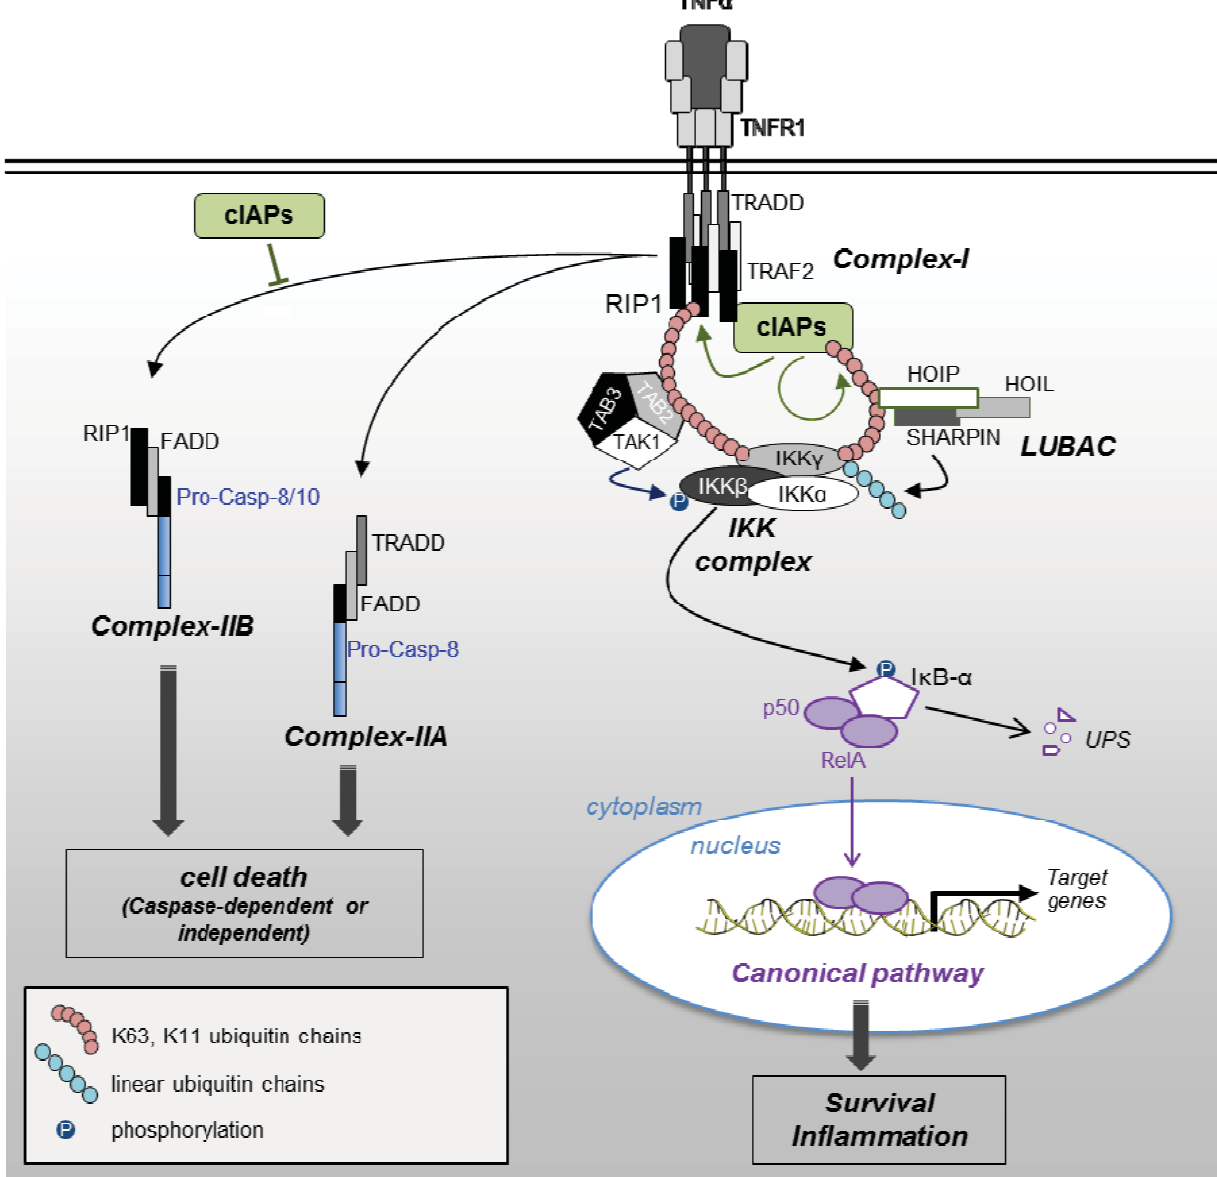
Figure 2. Regulation of TNFRI-signaling pathways by IAPs.TNF-R1 stimulation induces the recruitment to the receptor, of cIAPs and RIP1 via TRADD and TRAF2 into